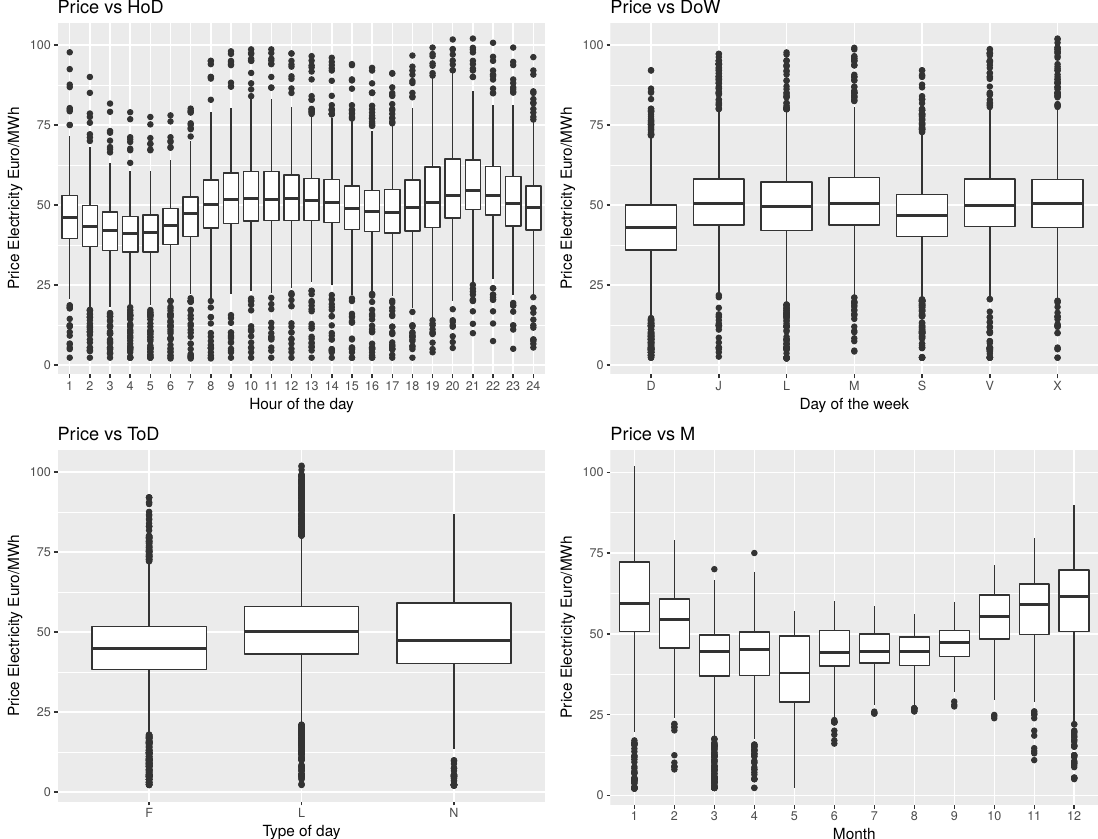
Figure 12. Boxplot price vs. hour of the day (HoD), day of the week (DoW) (D: Sunday, J: Thursday, L: Monday, M: Tuesday, S: Saturday, V: Friday and X: Wednesday), type of day (ToD) (F: weekend, L: working day, N: holiday) and month (M). Public source: